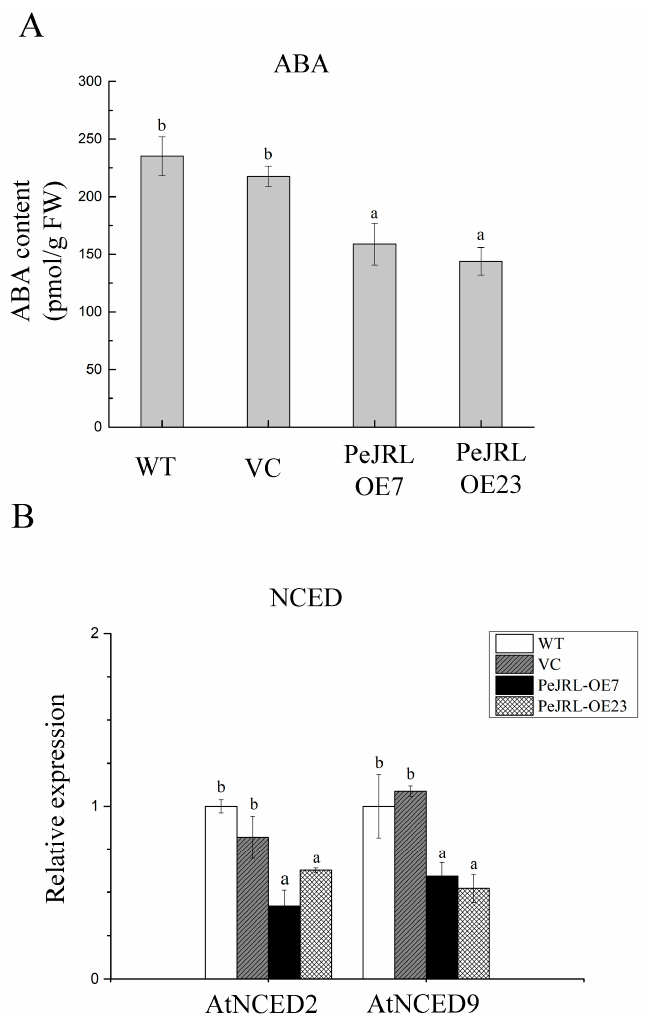
Figure 12. ABA content and expression of AtNCED2 and AtNCED9 in roots of wild-type (WT) Arabidopsis, vector control (VC), and PeJRL -transgenic lines (OE7 and OE23) under NaCl stress. Five-day-old seedlings were transferred to MS medium containing 75 mM NaCl for 10 days. ( A ) ABA content. ABA concentration was estimated using the enzyme-linked immunosorbent assay (ELISA) test. ( B ) Expression of AtNCED2 and AtNCED9 . AtNCED2 and AtNCED9 transcription were detected with RT-qPCR. The Arabidopsis AtACTIN2 was used as the internal control. Primers designed to target AtNCED2 , AtNCED9 , and AtACTIN2 genes are shown in Supplementary Materials Table S1. Each column corresponds to the mean of seven independent seedlings and columns labelled with different letters (a, b) indicate significant differences at p <